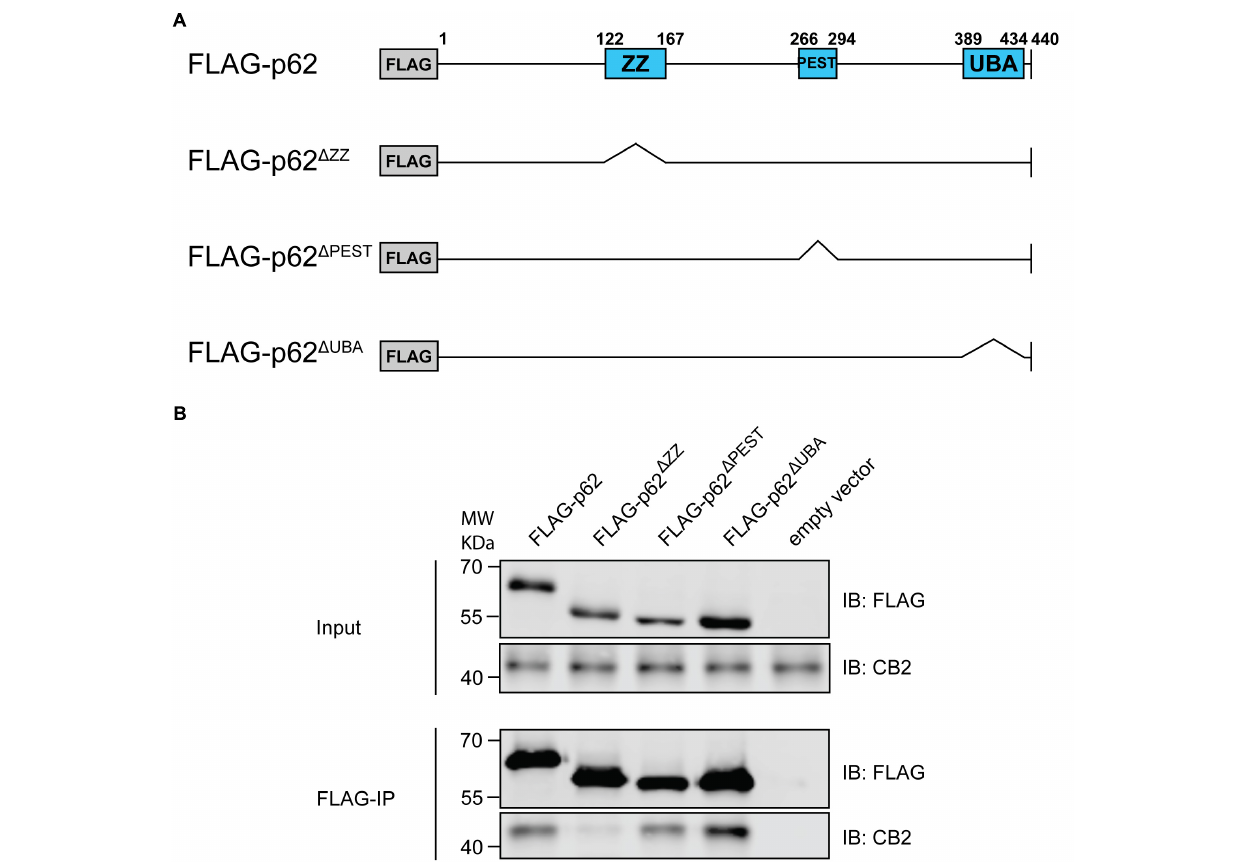
FIGURE 6 | (A) Schematic illustration of Flag-p62 deletion constructs for ZZ, PEST, and UBA motifs that were used for following co-immunoprecipitation experiments to identify interaction region. (B) Stably expressing HA-CB2 HEK293 cells were transiently transfected with different Flag-p62-deletion constructs, respectively. Protein extracts were used for precipitation of Flag-p62 using Flag antibody. The expression levels in input samples for CB2 and p62 were comparable in all constructs. Immunoprecipitation result of Flag-p62 (cid:49) ZZ revealed a significantly reduced coprecipitation of CB2 indicating that this domain in p62 is involved in the interaction with CB2. Representative results of three independent experiments were